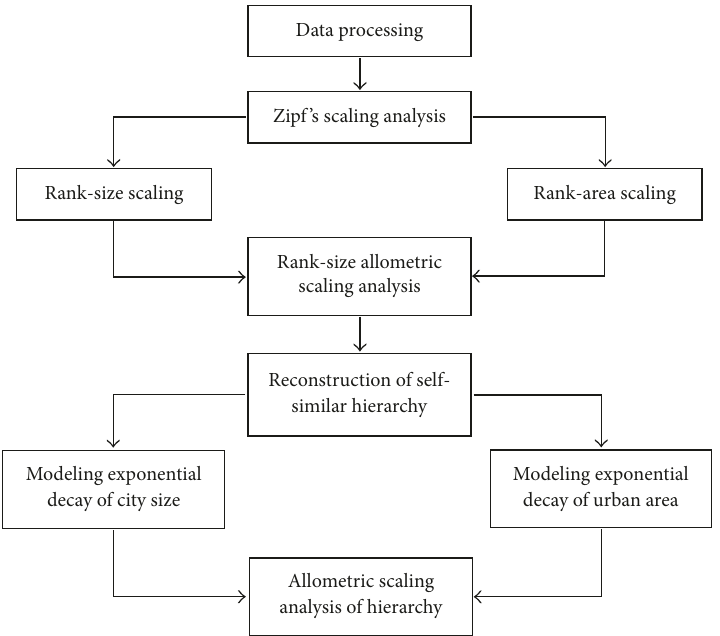
Figure 9: The general process of hierarchical rescaling and allometric analyses of urban